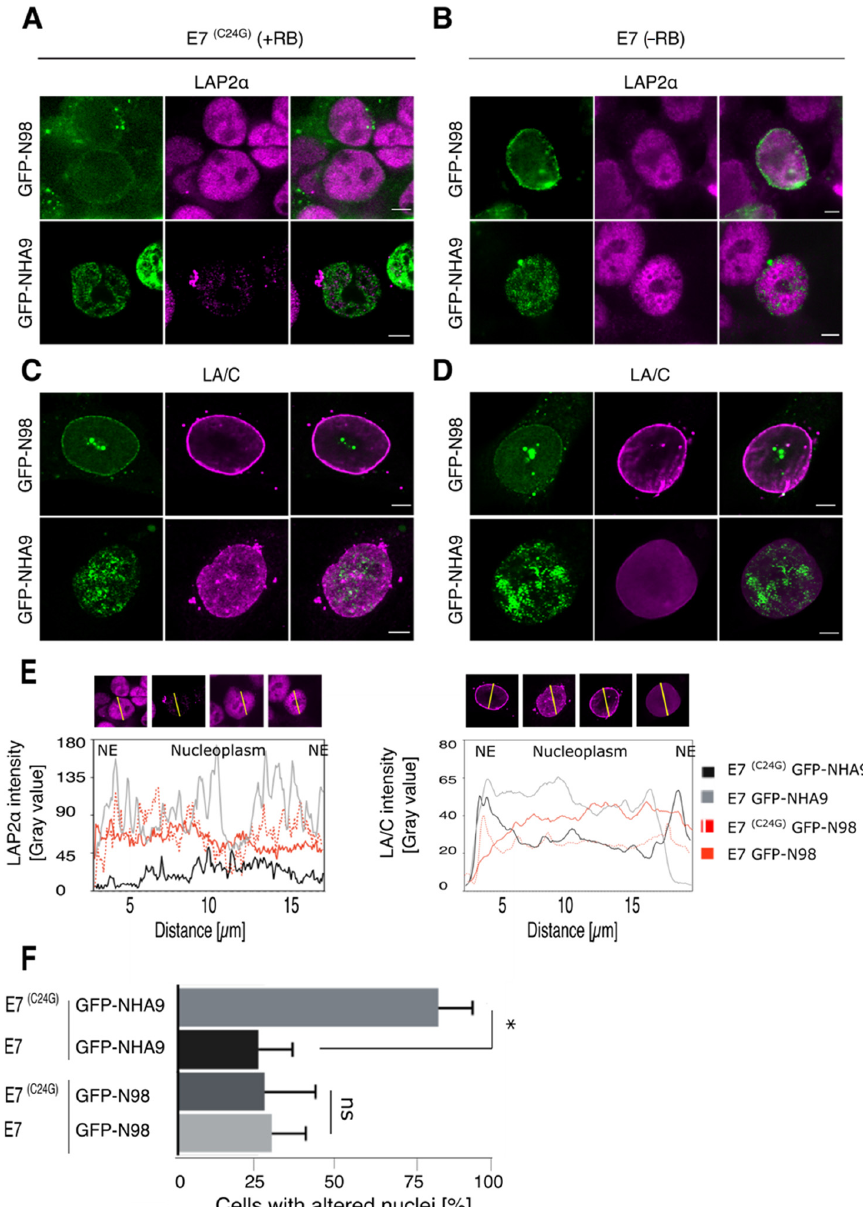
Figure 2. NUP98–HOXA9 affects LAP2 α and lamin A/C distribution in E7(C24G) expressing cells. HCT-116 cells stably expressing the HPV16 E7 protein (E7) or its inactive variant E7(C24G) were transiently transfected to express GFP-NHA9 and GFP-N98 and stained for immunofluorescence microscopy with the indicated antibodies. ( A ) Expression of GFP-NHA9 (green) provoked a reduced LAP2 α staining (magenta) in the nucleoplasm in E7(C24G) cells, ( B ) but not in cells lacking RB due to the expression of wild-type E7. Expression of GFP-N98 (green) had no impact on the LAP2 α pattern in either background. ( C ) Lamin A/C (LA/C, magenta) was displaced to the nucleoplasm in the presence of GFP-NHA9 (green) and adopted a punctuated pattern in E7(C24G) cells as compared to E7 expressing cells ( D ). In contrast, LA/C was enriched at the nuclear envelope (NE) in GFP-N98 (green) expressing cells, irrespective of the RB status. Shown are representative confocal images. Scale bars, 5 µ m. ( E ) Fluorescence intensity of LAP2 α and LA/C staining was determined along the axis shown as line in the fluorescence images and plotted as a graph. Fluorescence intensity was normalized to DAPI. ( F ) Quantification of cells with altered LAP2 α distribution. About 400 cells were analyzed for each sample. The number of experiments for LAP2 α and LA/C staining was: n = 4; * p < 0.05, ns, p not significant, t -test, two-tailed.